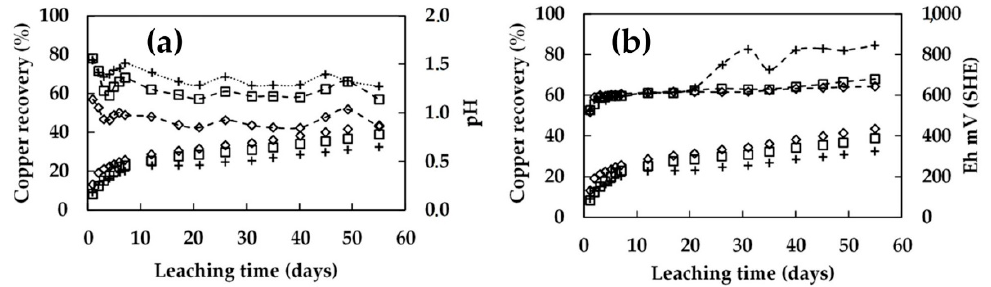
Figure 5. Effects of acid concentration and continuous irrigation on the extraction of column leaching of chalcopyrite ore. +, 6 g/L H + ; □, 10 g/L H + ; ◊, 20 g/L H + . ( a ) Variation in the pH level (dashed line); ( b ) variation in the redox potential (dashed line).